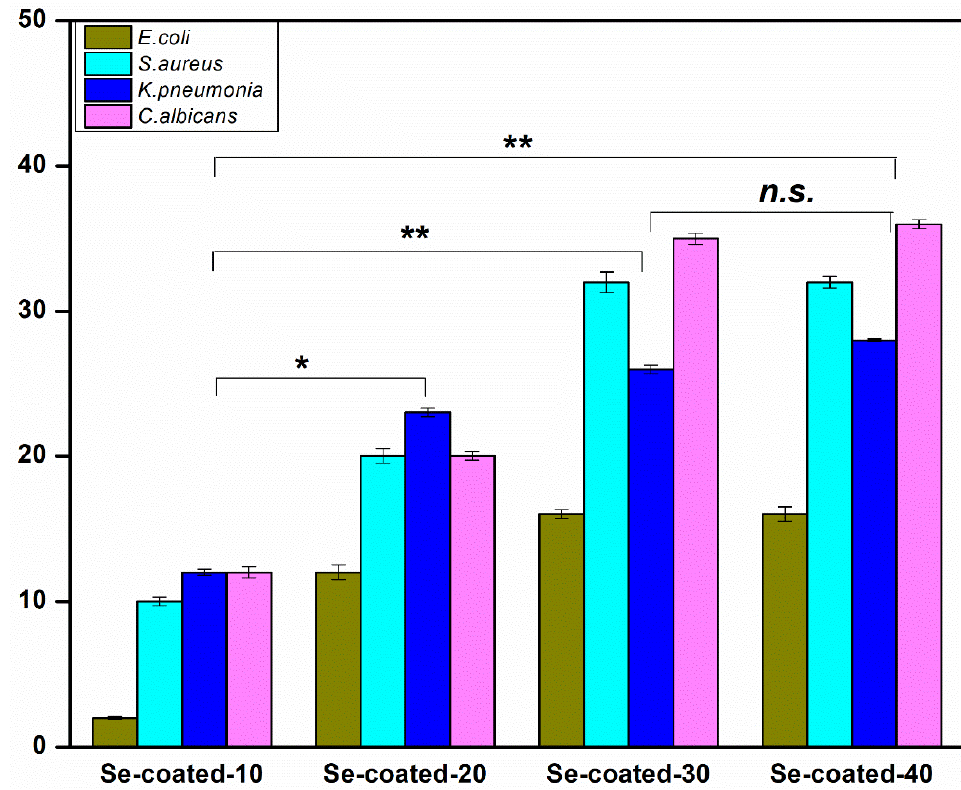
Figure 3. Antimicrobial activity of Se-coated samples against three bacterial and one fungal strain. Data are represented as mean with standard deviation ( n = 3). * p ≤ 0.05, ** p ≤ 0.01 represent statistical significance between Se-coated samples (Mann–Whitney test) and n.s. = no significance.